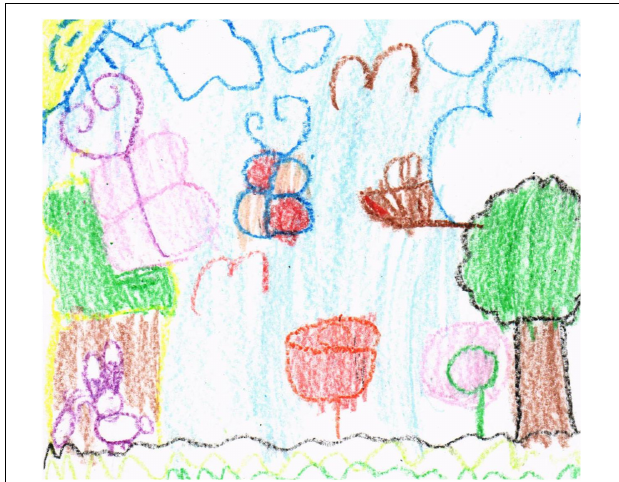
FIGURE 3 | Drawing with proper symbolic representation.